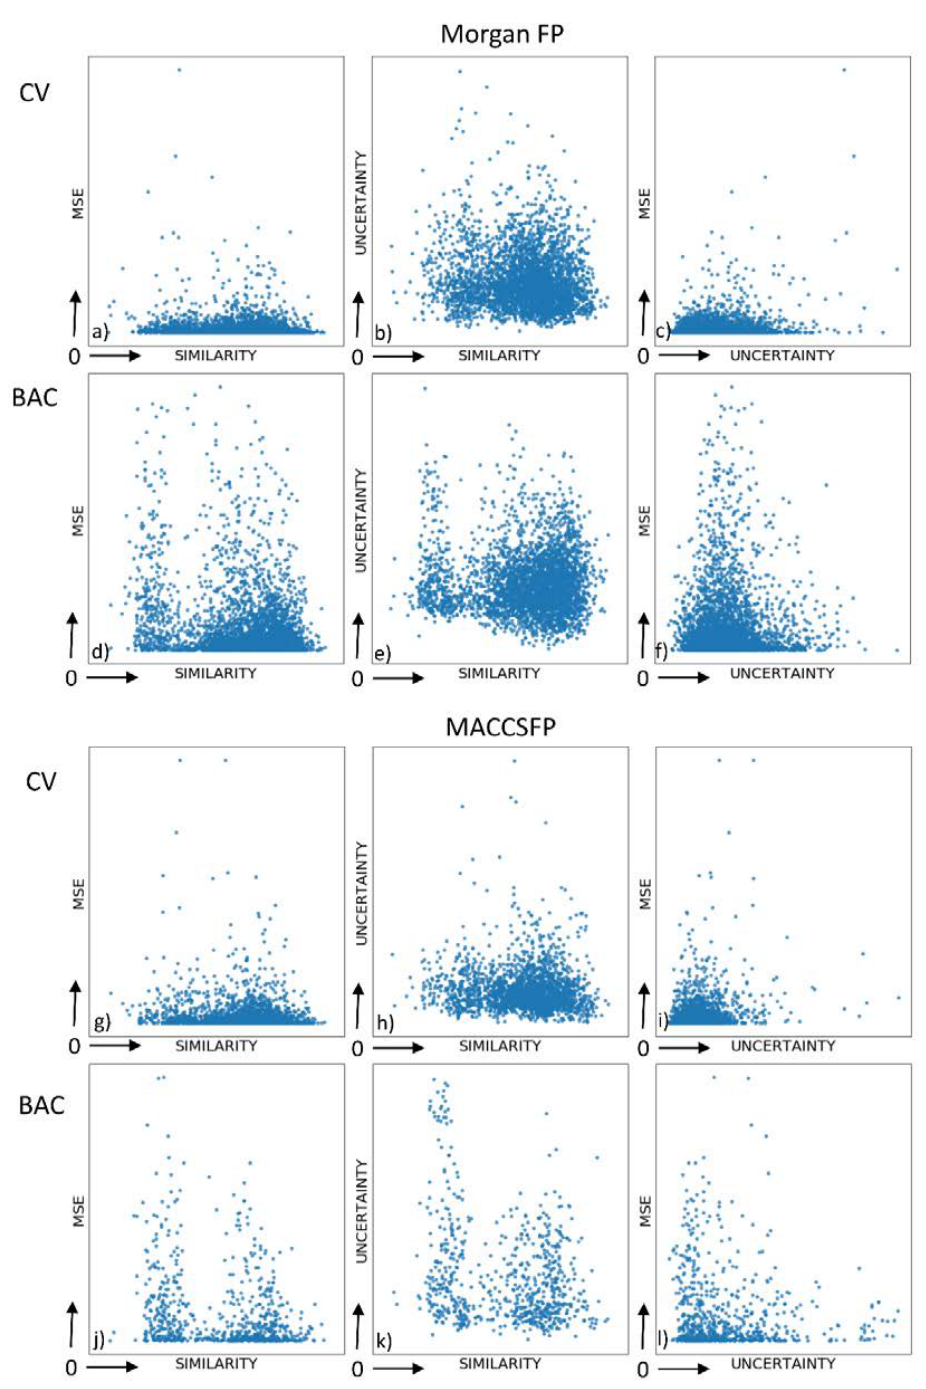
Figure 1. Visual analysis of dependencies between mean squared error (MSE), prediction uncertainty and compound similarity for adenosine A 1 receptor. ( a ) MSE vs. similarity for Morgan FP in CV; ( b ) uncertainty vs. similarity for Morgan FP in CV ( c ) MSE vs. uncertainty for Morgan FP in CV; ( d ) MSE vs. similarity for Morgan FP in BAC; ( e ) uncertainty vs. similarity for Morgan FP in BAC; ( f ) MSE vs. uncertainty for Morgan FP in BAC; ( g ) MSE vs. similarity for MACCSFP in CV; ( h ) uncertainty vs. similarity for MACCSFP in CV ( i ) MSE vs. uncertainty for MACCSFP in CV; ( j ) MSE vs. similarity for MACCSFP in BAC; ( k ) uncertainty vs. similarity for MACCSFP in BAC; ( l ) MSE vs. uncertainty for MACCSFP in BAC.